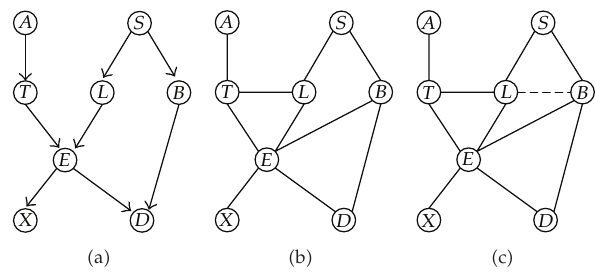
Figure 1: Asia network, its moral graph, and one of its triangulation graphs.